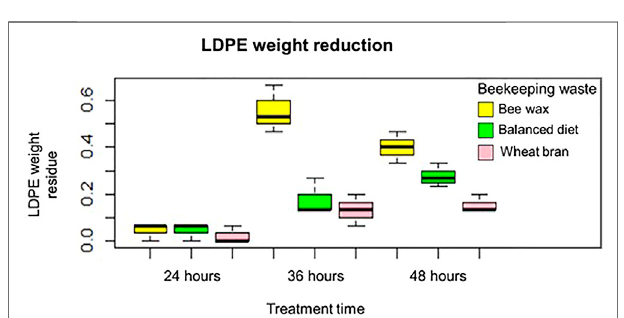
FIGURE 3 | LDPE weight reduction.